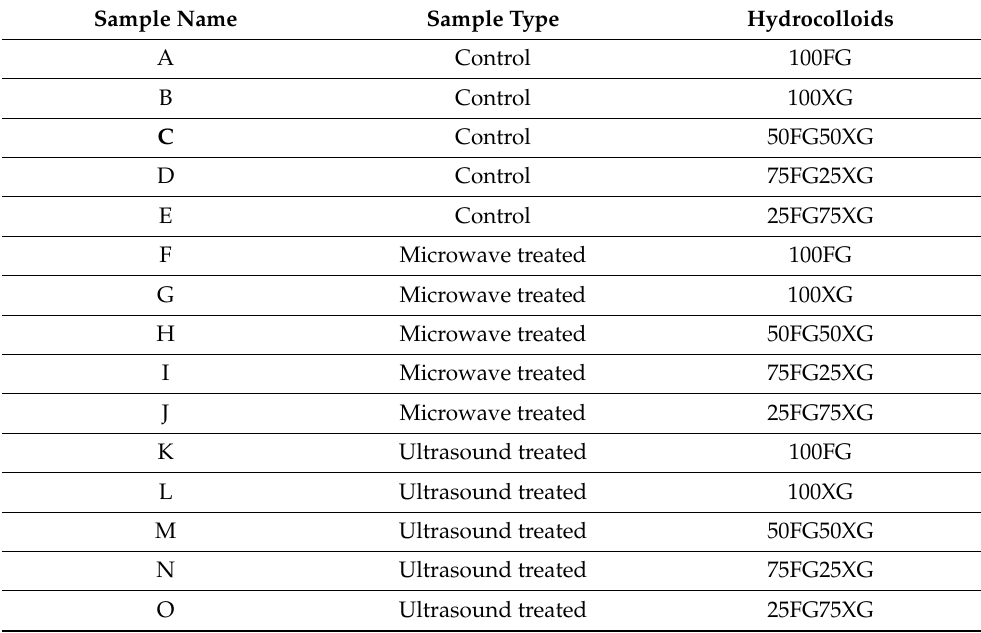
Table 1. The list of emulsions containing two biopolymers treated with microwaves and